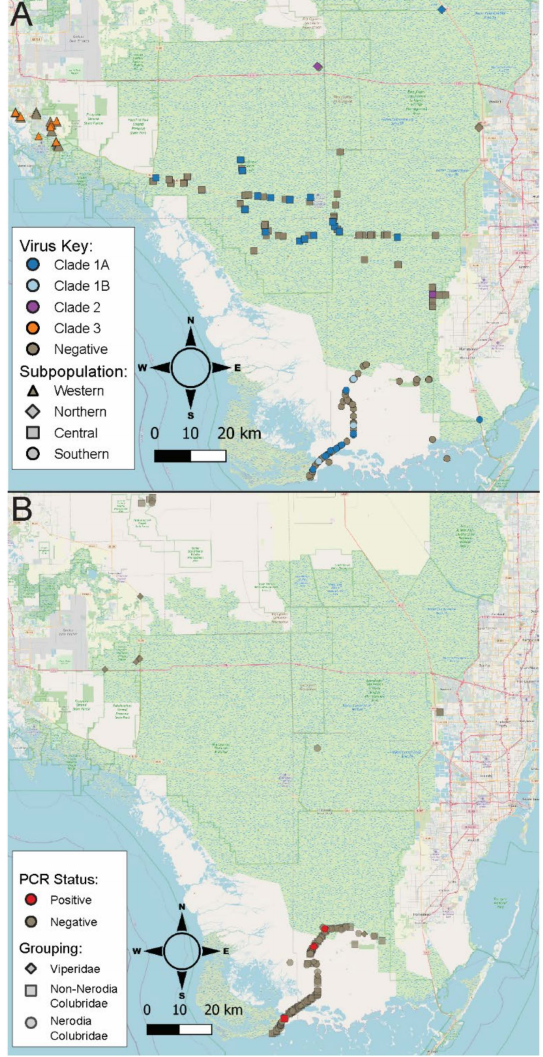
Figure 1. Maps of invasive Burmese python ( A ) and native snake ( B ) sampling and reverse tran- scription PCR (rtPCR) serpentovirus positive distribution in Florida, USA. Pythons of the western subpopulation had endemic virus clade 3, northern subpopulation clade 1A and clade 2, central subpopulation clade 1A and clade 2, and southern subpopulation clade 1A and endemic clade